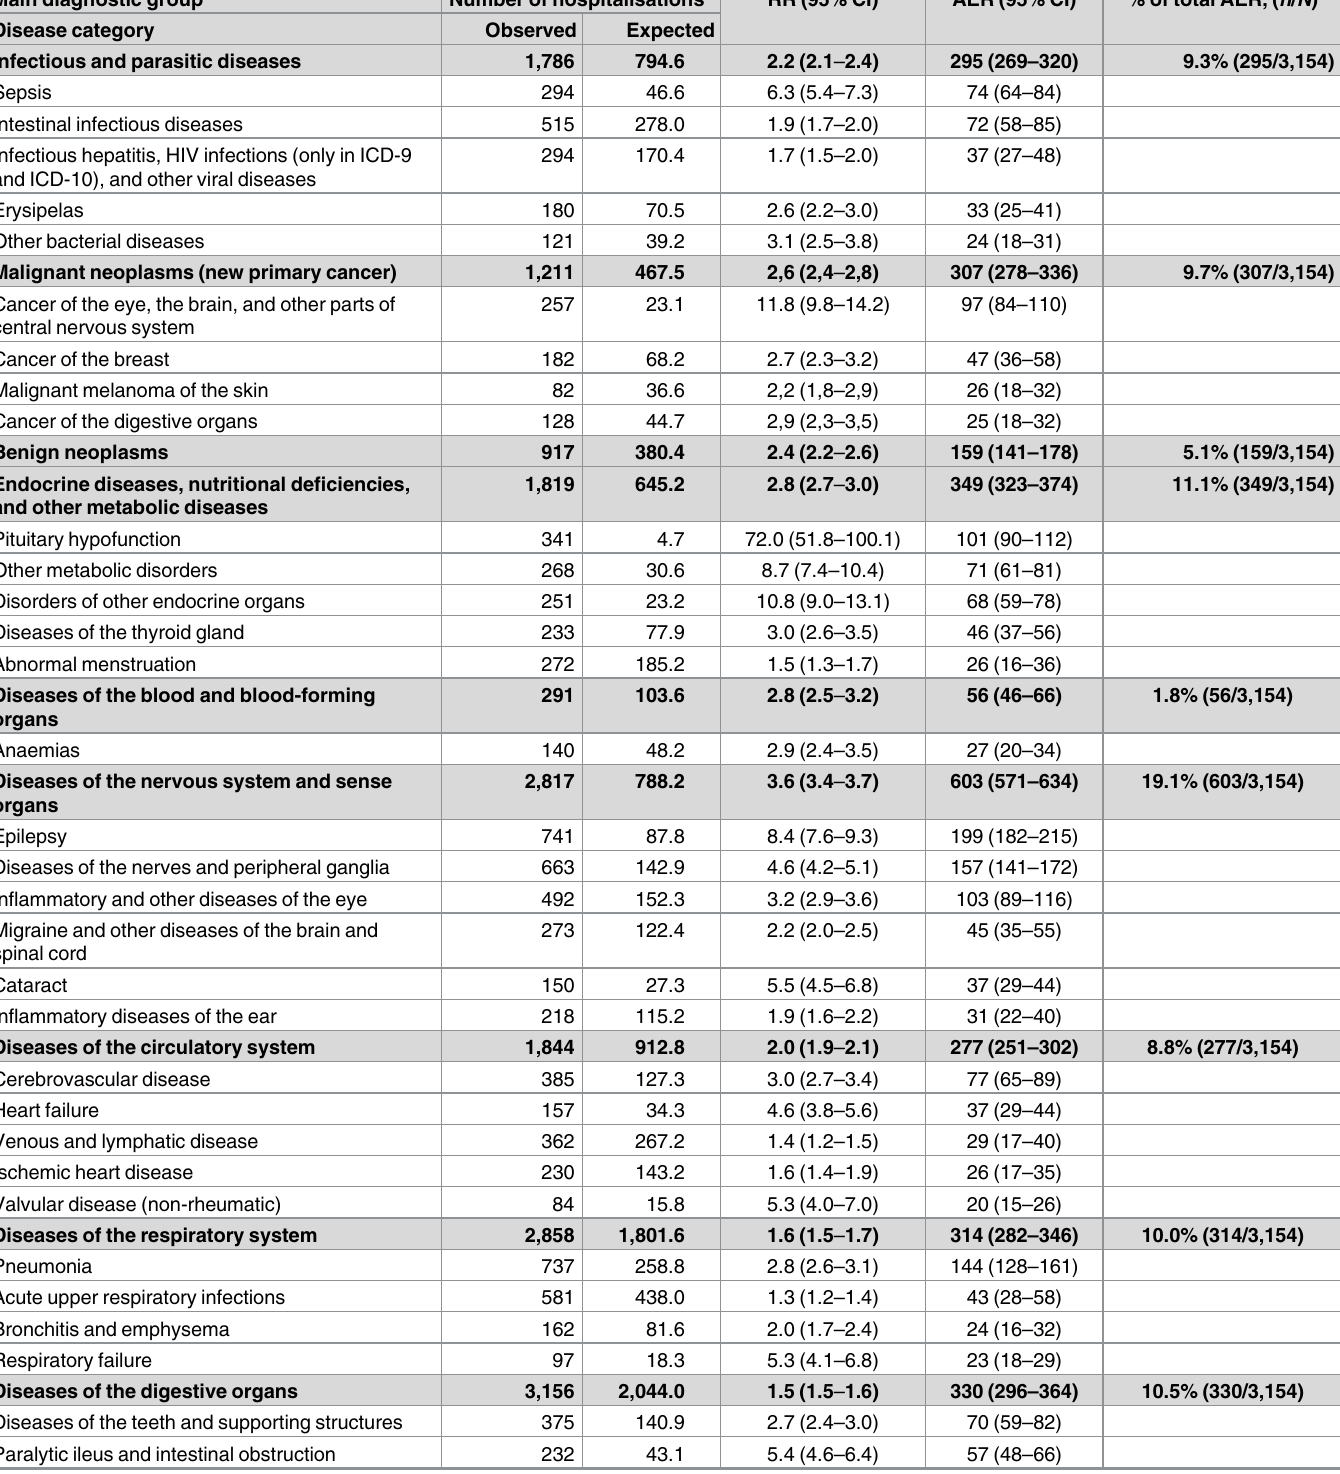
Table 3. Standardised hospitalisation rate ratios (RRs), absolute excessrisks (AERs), and the percentage (%) of total AER for main diagnostic groups and selected disease categories distinguished by AER (cid:21)